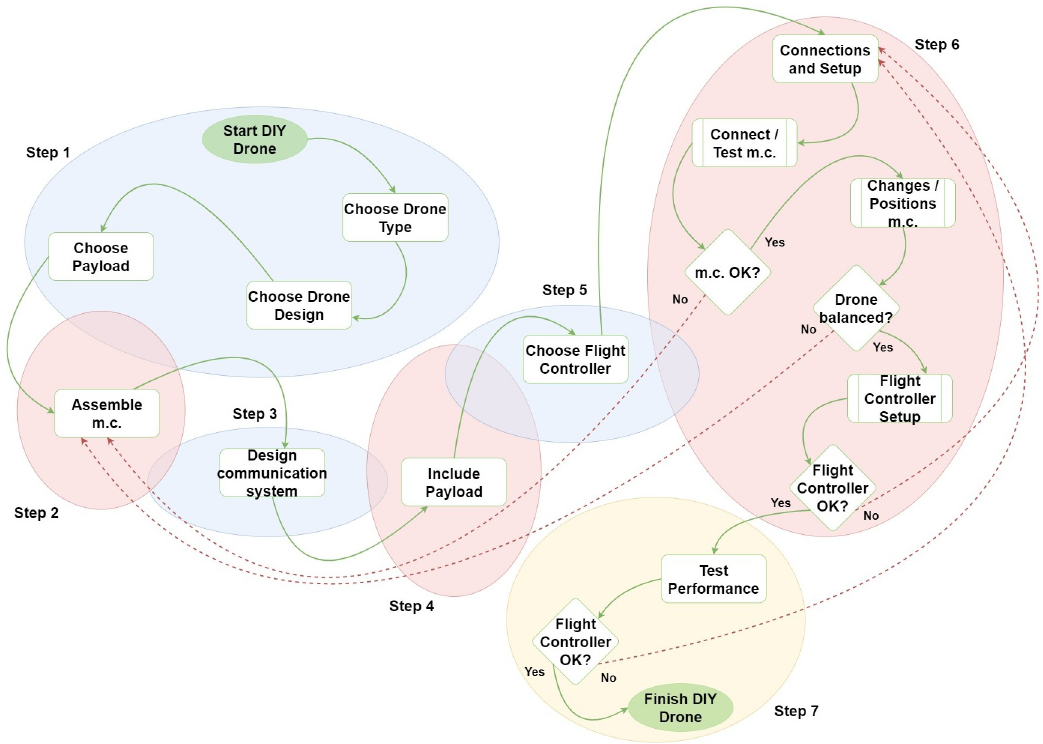
Fig 1. General DIY workflow. m.c. means main components. Blue balloons are pre-development phase, Red balloons are development phase and the yellow balloon is post-development phase.